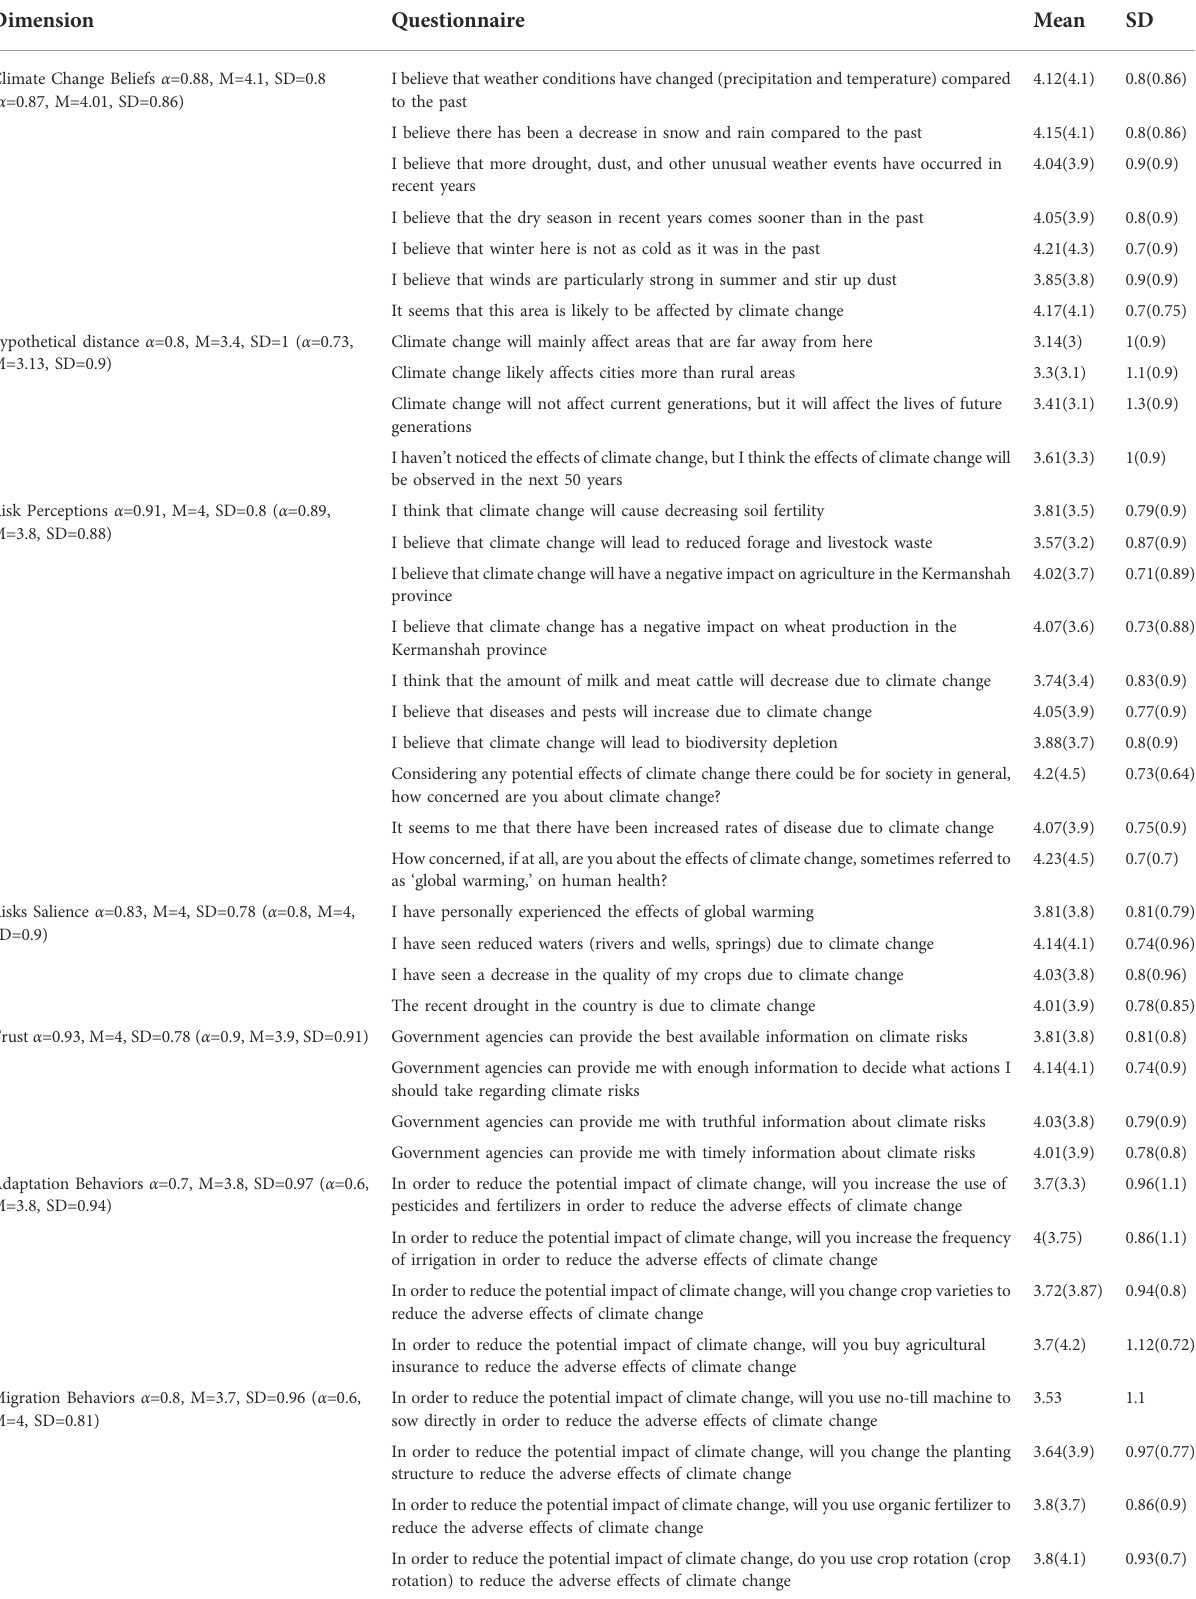
TABLE 1 Summary of questionnaire